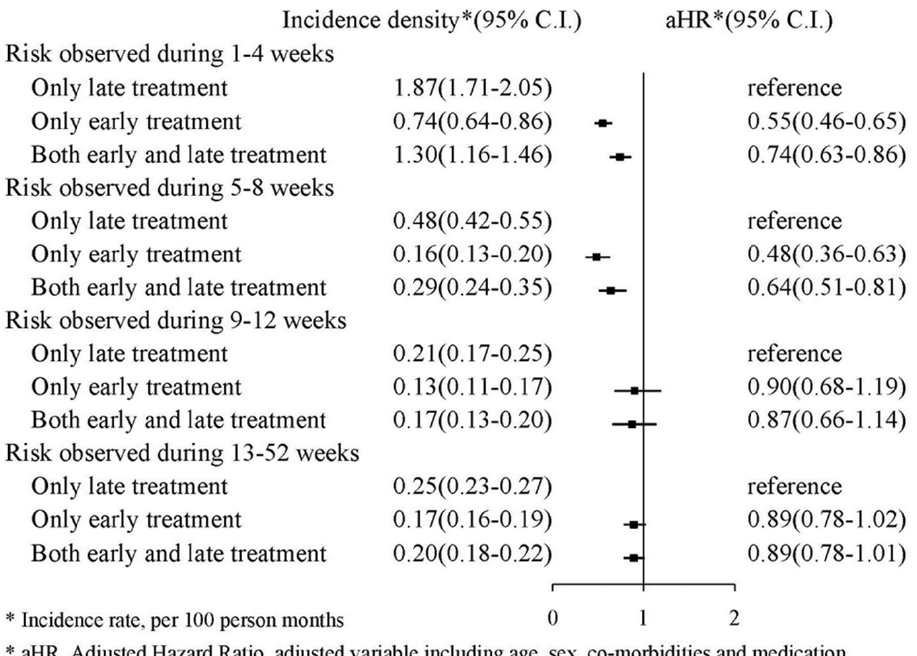
Figure 5. The forest plot analysis indicated no significant association between thromboem- bolic events and early or late TXA treatment (aHR: 1.03, 95% CI: 0.94–1.12). The Kaplan–